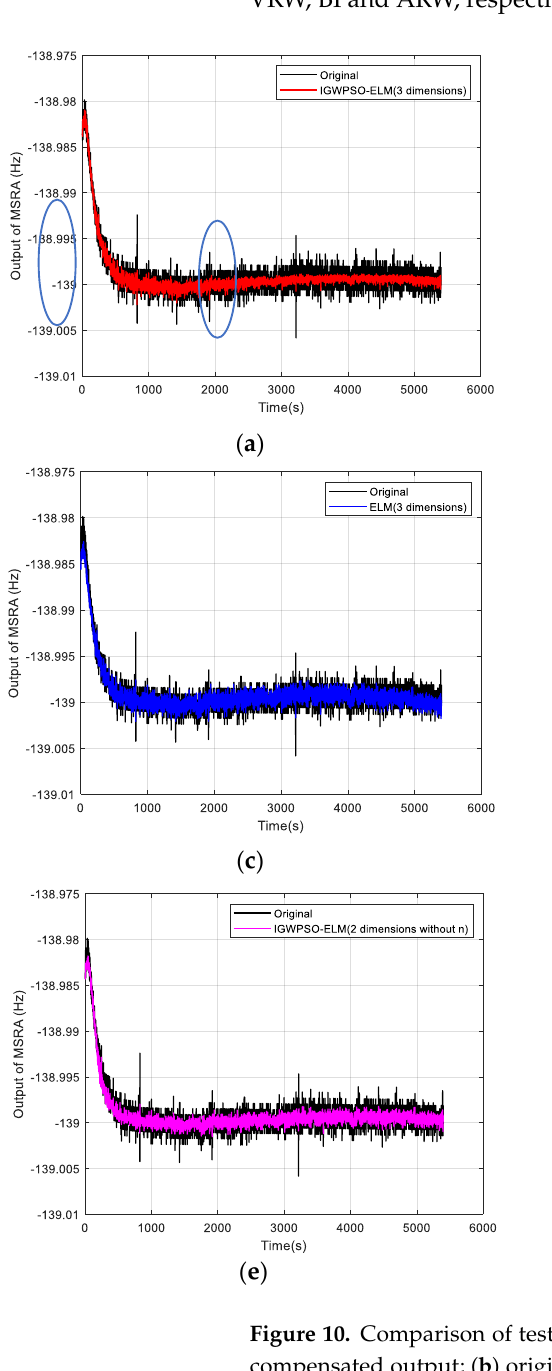
Figure 9. The testing environment.